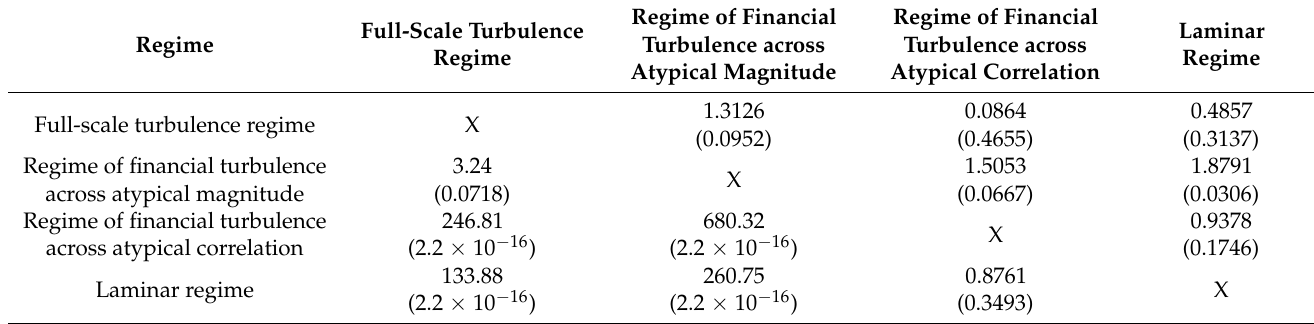
Table 8. Pair-wise consistency check of hidden regime features for the RTSI (the p -value is given in